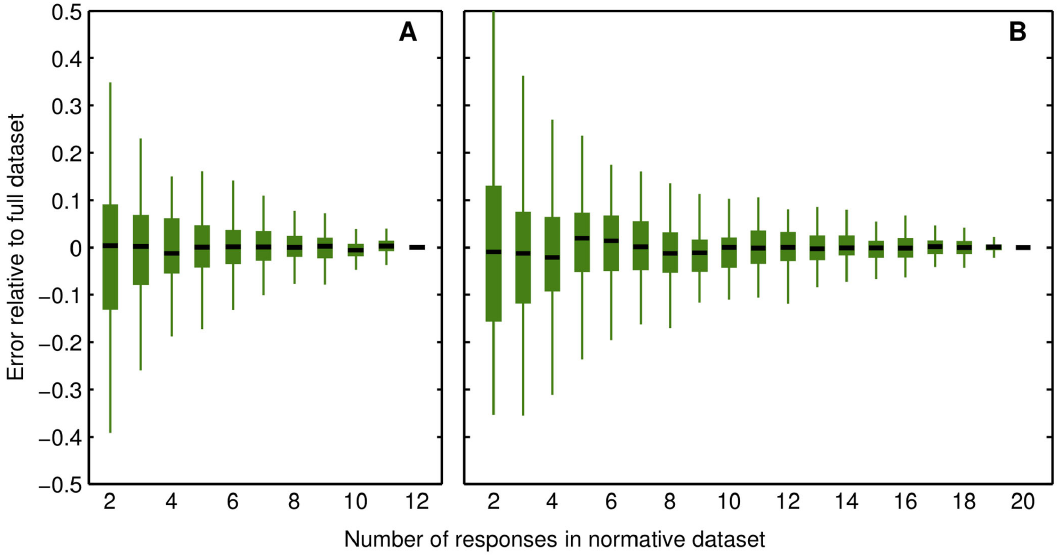
Figure 2. Error distribution of shared word scores for smaller dataset sizes. Error of the mean word score, relative to the score for the full normative dataset, as a function of the size of the A) lab-sourced dataset, or B) crowdsourced dataset. There were 100 random samples for each set size. Boxes indicate the interquartile range (IQR), the whiskers contain the range + / 2 1.5 * IQR beyond the limits of the boxes (corresponding to 99.7% of the area of a normal distribution).